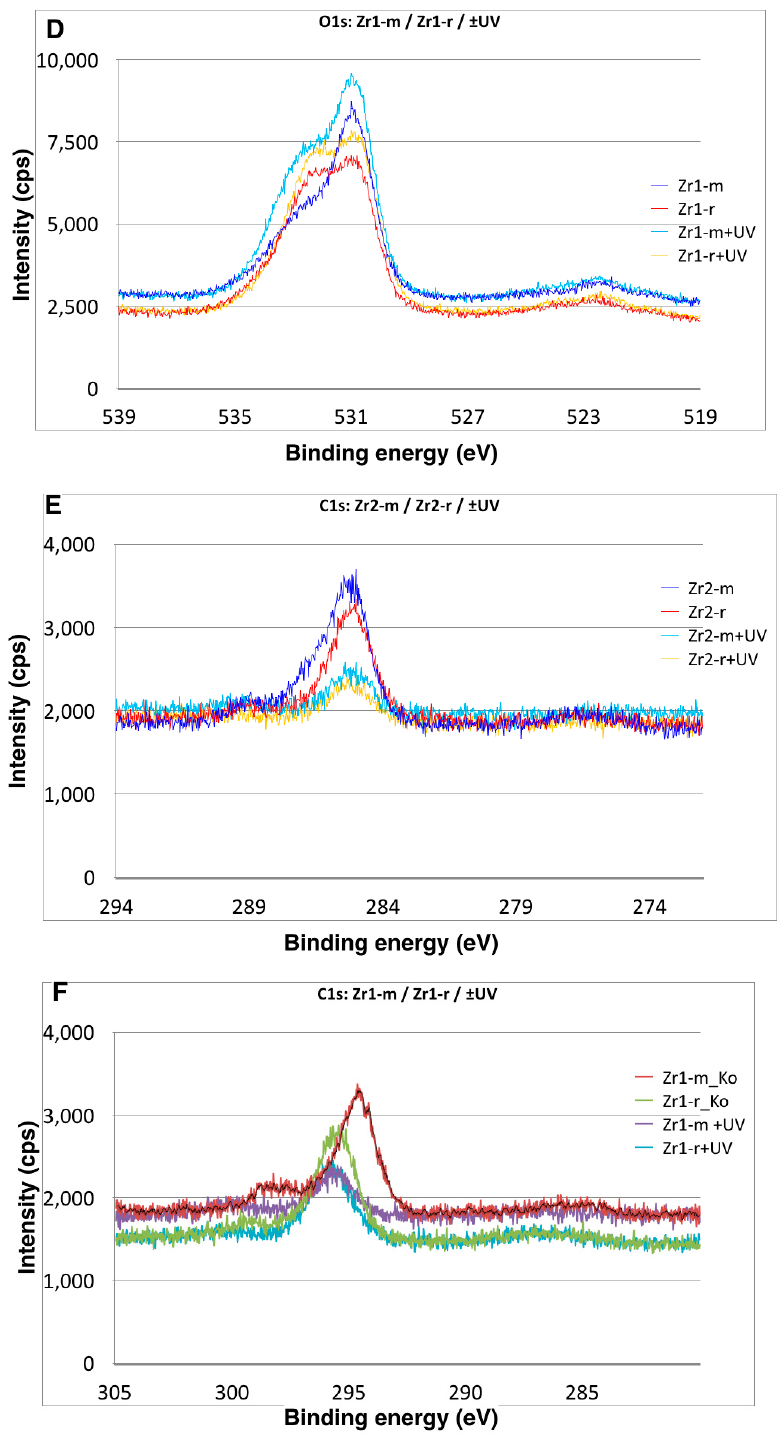
Figure 7. A close-up view of the XPS peaks for ( A , B ) Zr3d, ( C , D ) O1s and ( E , F ) C1s of the Zr1-m, Zr1-r, Zr2-m and Zr2-r surfaces, indicating changes in the atomic percentage of surface C, O and Zr after UV treatment.